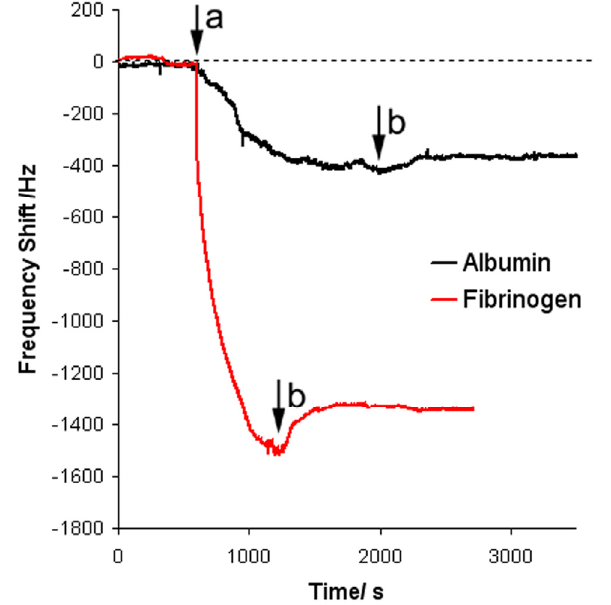
Figure 5 . Protein detection using an SU-8 Love wave device. Arrows indicate points when solutions over sensors were exchanged, a) protein solution injected, prior to a) and at b) PBS solutions injected. Adsorption of albumin (black line) and fibrinogen (red line) was